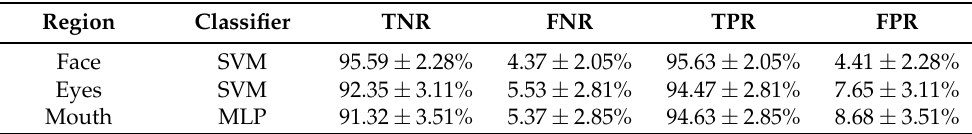
Table 5. Performance results for the detection of palsy